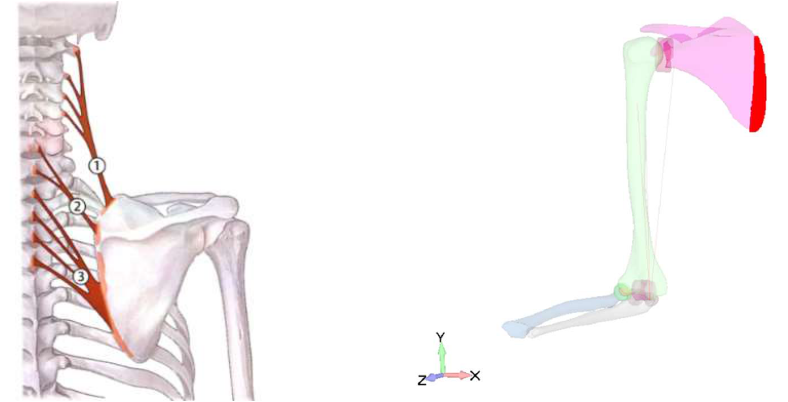
Figure 7. Boundary condition, muscles fixing scapula ( left ), constrain in FEA model, ( right ), scapula fixed.